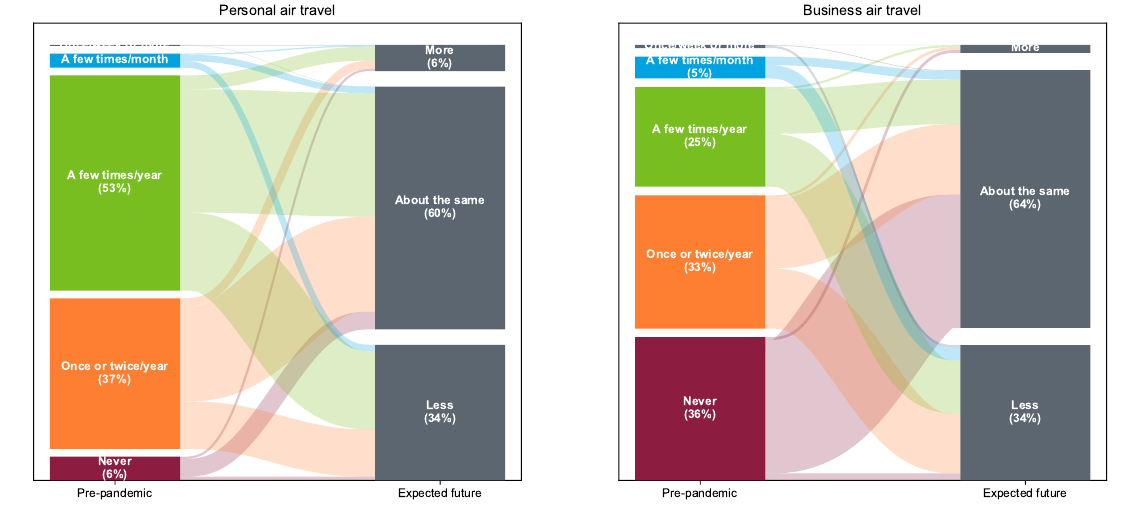
Figure 5. Expected change in personal and business air travel after the pandemic, relative to before. Business air travel is only for individuals who reported working before or during the pandemic ( n = 1159), while personal is for all respondents who answered the question ( n = 1313). We also asked respondents to select the reason they anticipate changes in their air